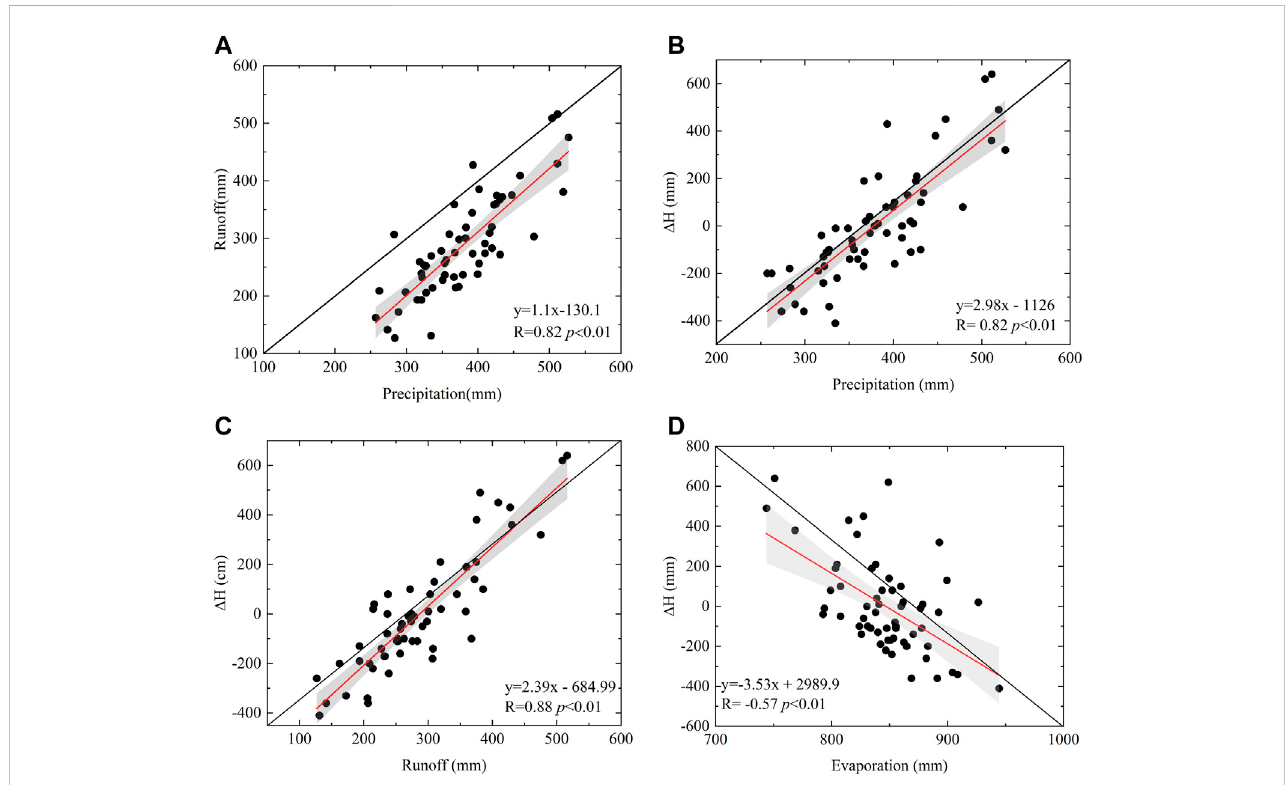
FIGURE 7 Relationshipbetweenprecipitationandrunoff (A) ,precipitationand Δ H (obtainedfromEq.3) (B) ,riverrunoffand Δ H (C) ,andevaporationand Δ H (D) .The black solid line is the 1:1 line, while the red solid line is the regression fi t between variables, gray shading is the 0.95 con fi dence interval of the fi tting